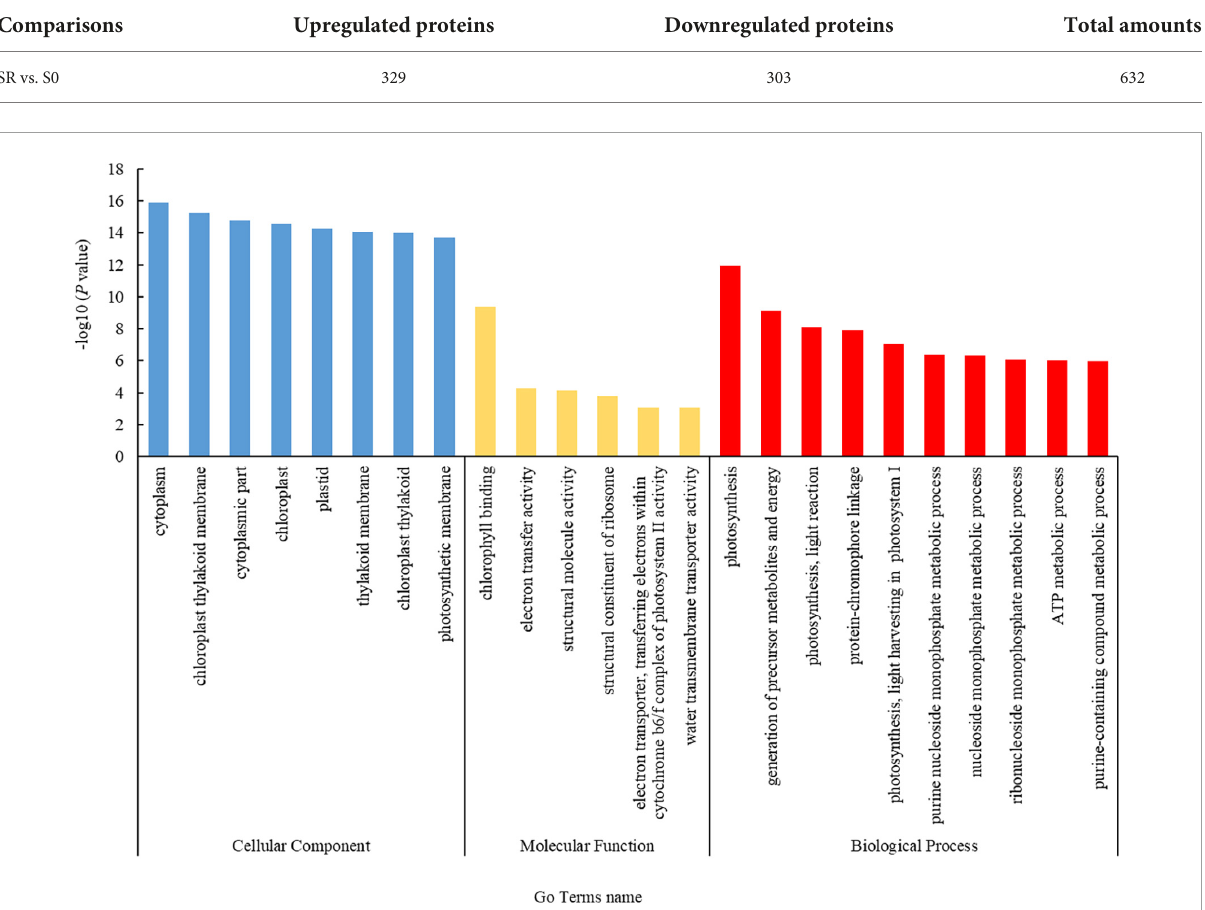
TABLE 3 Statistics protein quantitative differences.